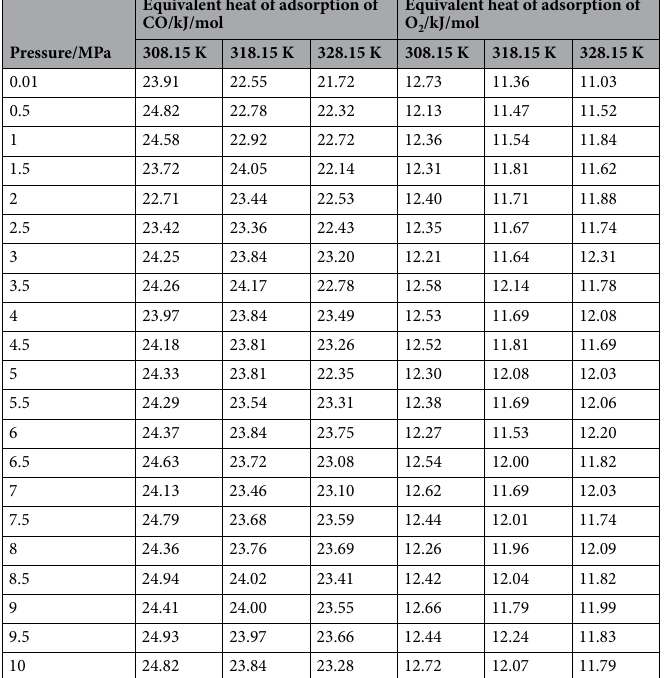
Table 6. Equivalent heat of adsorption of single-component CO and O 2 at different pressures and